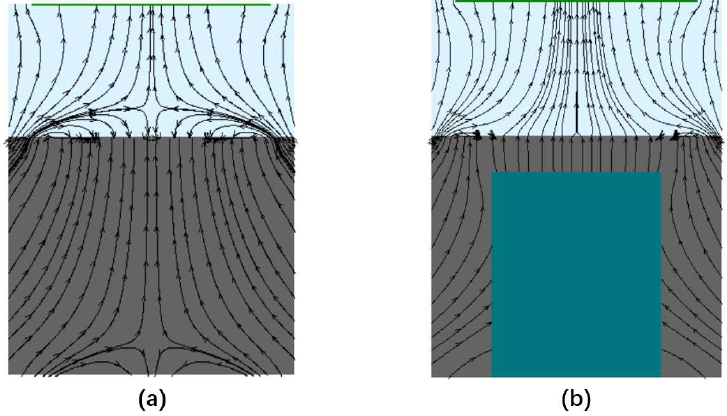
Figure 6. Gas flow field: ( a ) in the traditional structure model and ( b ) in the optimized structure model.